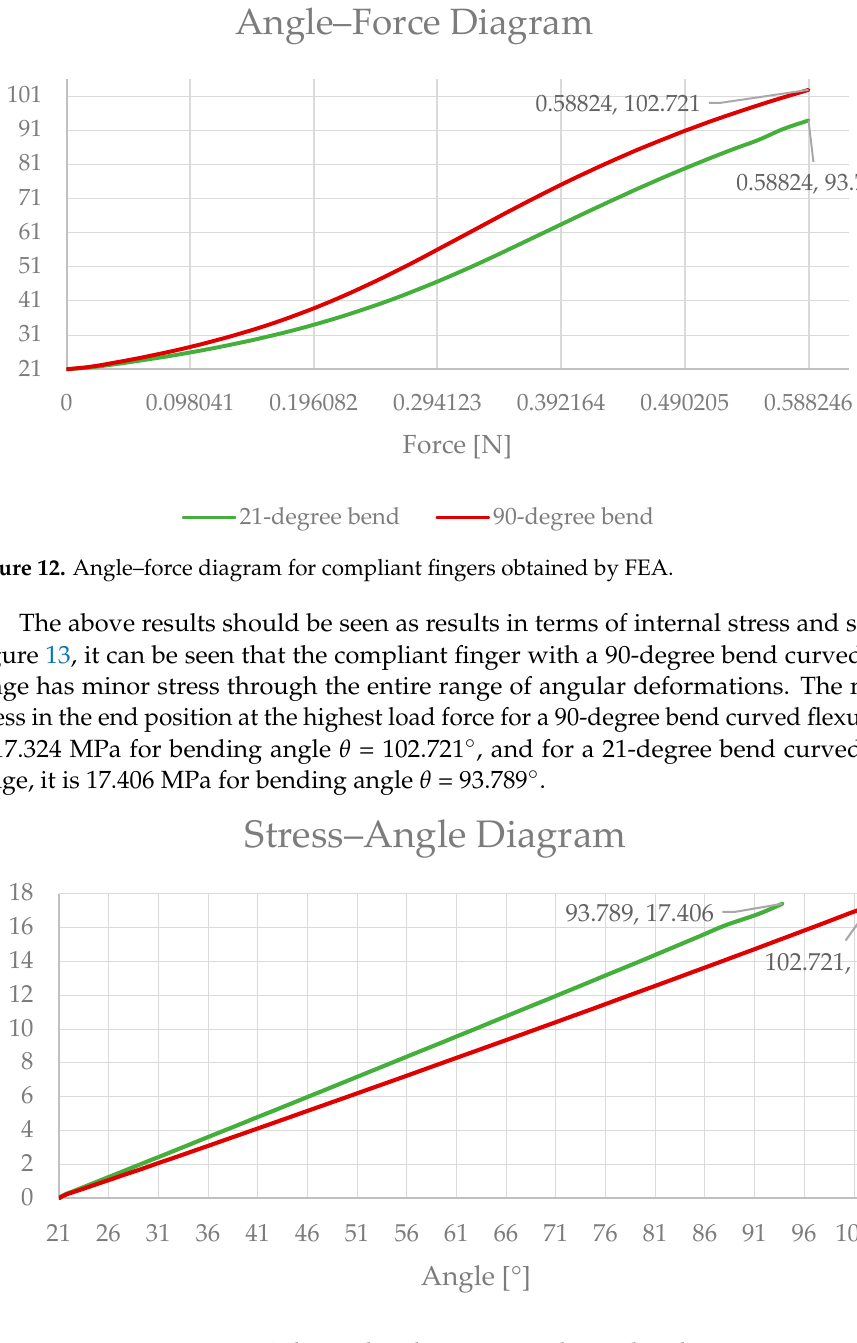
( b ) Figure 14. Example of computer vision measured bending angle 𝜃 for compliant finger with ( a ) curved flexure hinge with a 21-degree bend and ( b ) curved flexure hinge with a 90-degree bend, for a loaded 30 g weight. Table 5 shows the newly obtained results of the experiment (Computer Vision Method) and FEA. The results presented in this way clearly confirm the similarity be- tween FEA and experimental results in the area up to 70 degrees for curved flexure hinge with a 21-degree bend and up to 80 degrees for curved flexure hinge with a 90-degree bend. In the area larger than the above-mentioned angles, the results diverge. This out- come can be attributed to the behavior of the material, which in the area of large defor- mations tends to creep after the addition of weights heavier than 40 g. With the graphic in Figure 13, this can be confirmed because, in these areas, the stress is greater than 12 MPa for both compliant fingers. This also refers to Figure 11, where, as already noted, the material enters the non-linear deformation region.